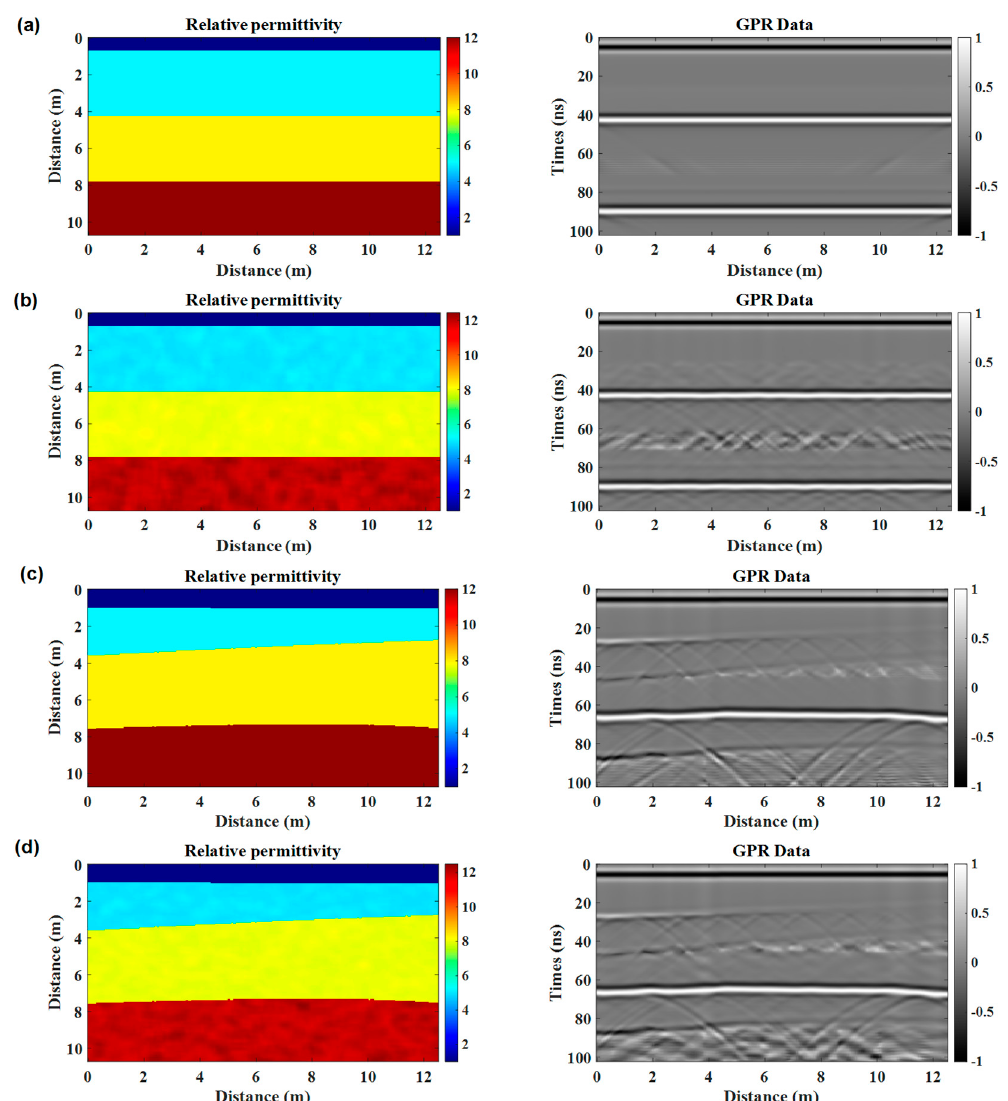
Figure 4. Relative permittivity distribution of the model and the time-domain GPR profile obtained by FDTD. ( a ) Horizontal layered media model; ( b ) horizontal stochastic media model; ( c ) undulating-interface layered media; ( d ) undulating-interface stochastic media model.